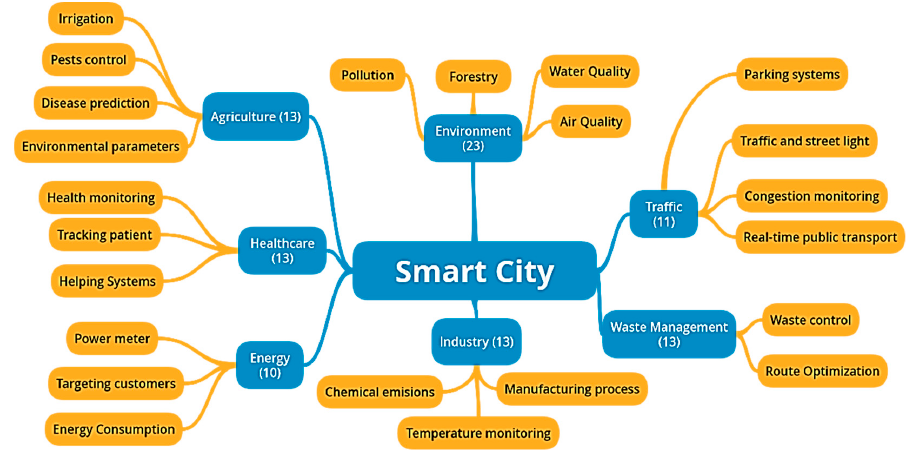
Figure 10. Types of LoRa applications in the smart city.